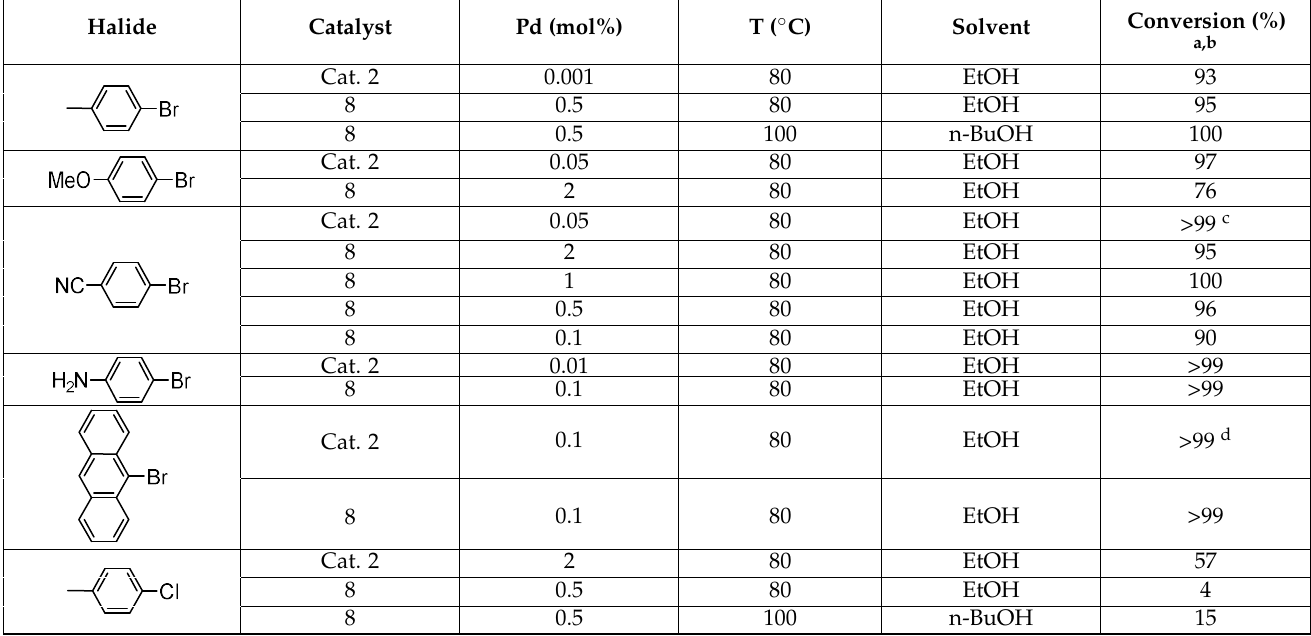
Table 1. Compared results obtained with compound 8 and the reference catalyst 2. Halide Catalyst